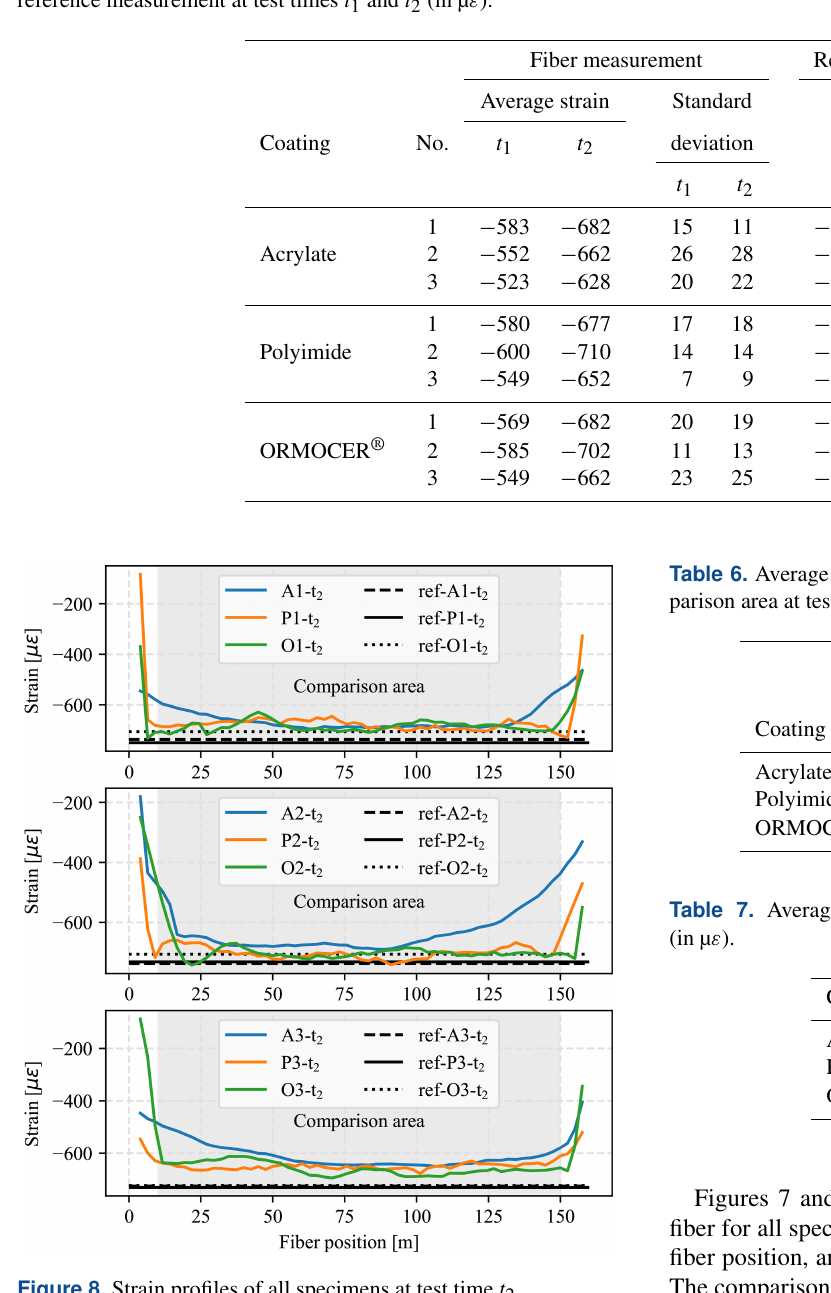
Table 5. Strain values and standard deviation in the comparison area of the fiber measurement compared with the strain values of the reference measurement at test times t 1 and t 2 (in µ ε ).